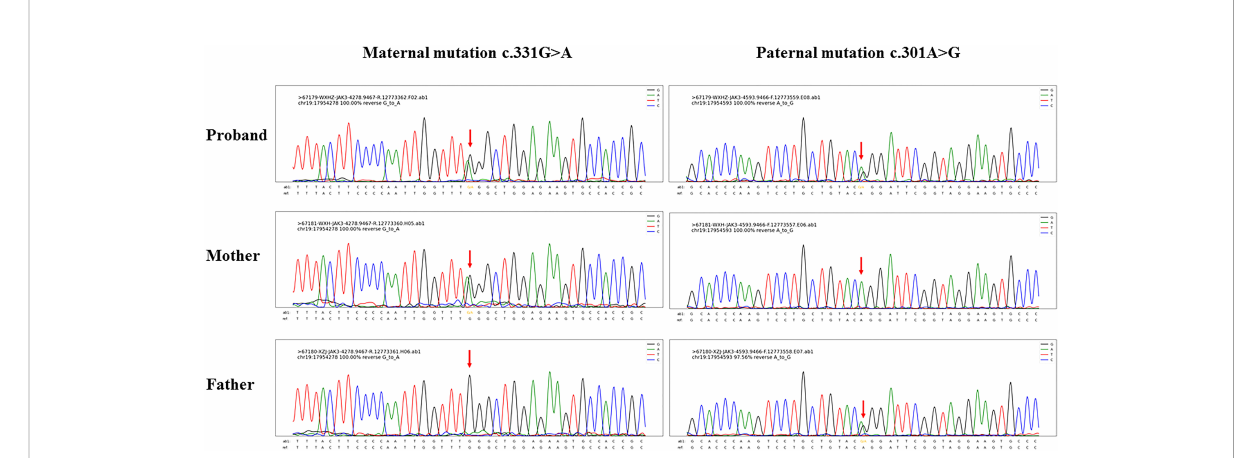
FIGURE 1 Gene sequencing results of the index patient of Janus kinase 3 ( JAK3 ) de fi ciency and her parents. Sequencing detected two missense mutations both located in the Janus homology 7 (JH7) domain of the JAK3 gene, as maternal mutation c.331G>A and paternal mutation